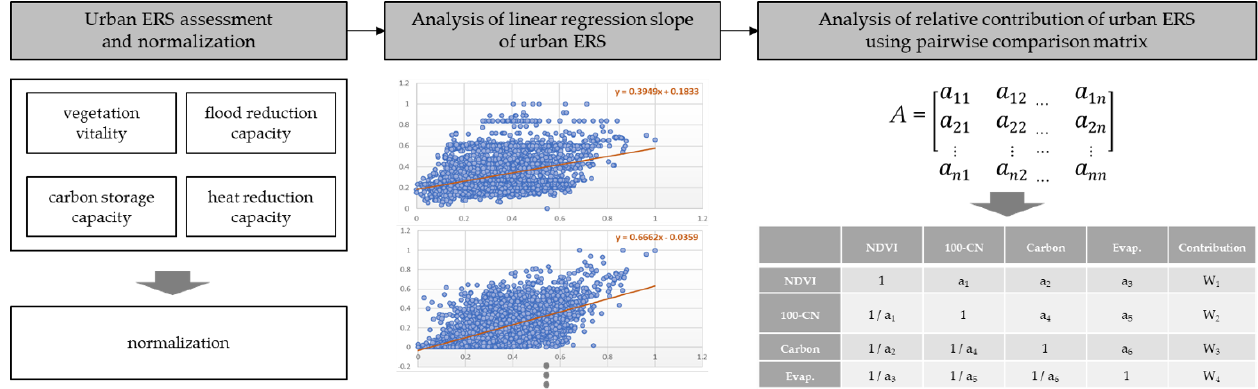
Figure 3. Relative contribution analysis method between ERS.